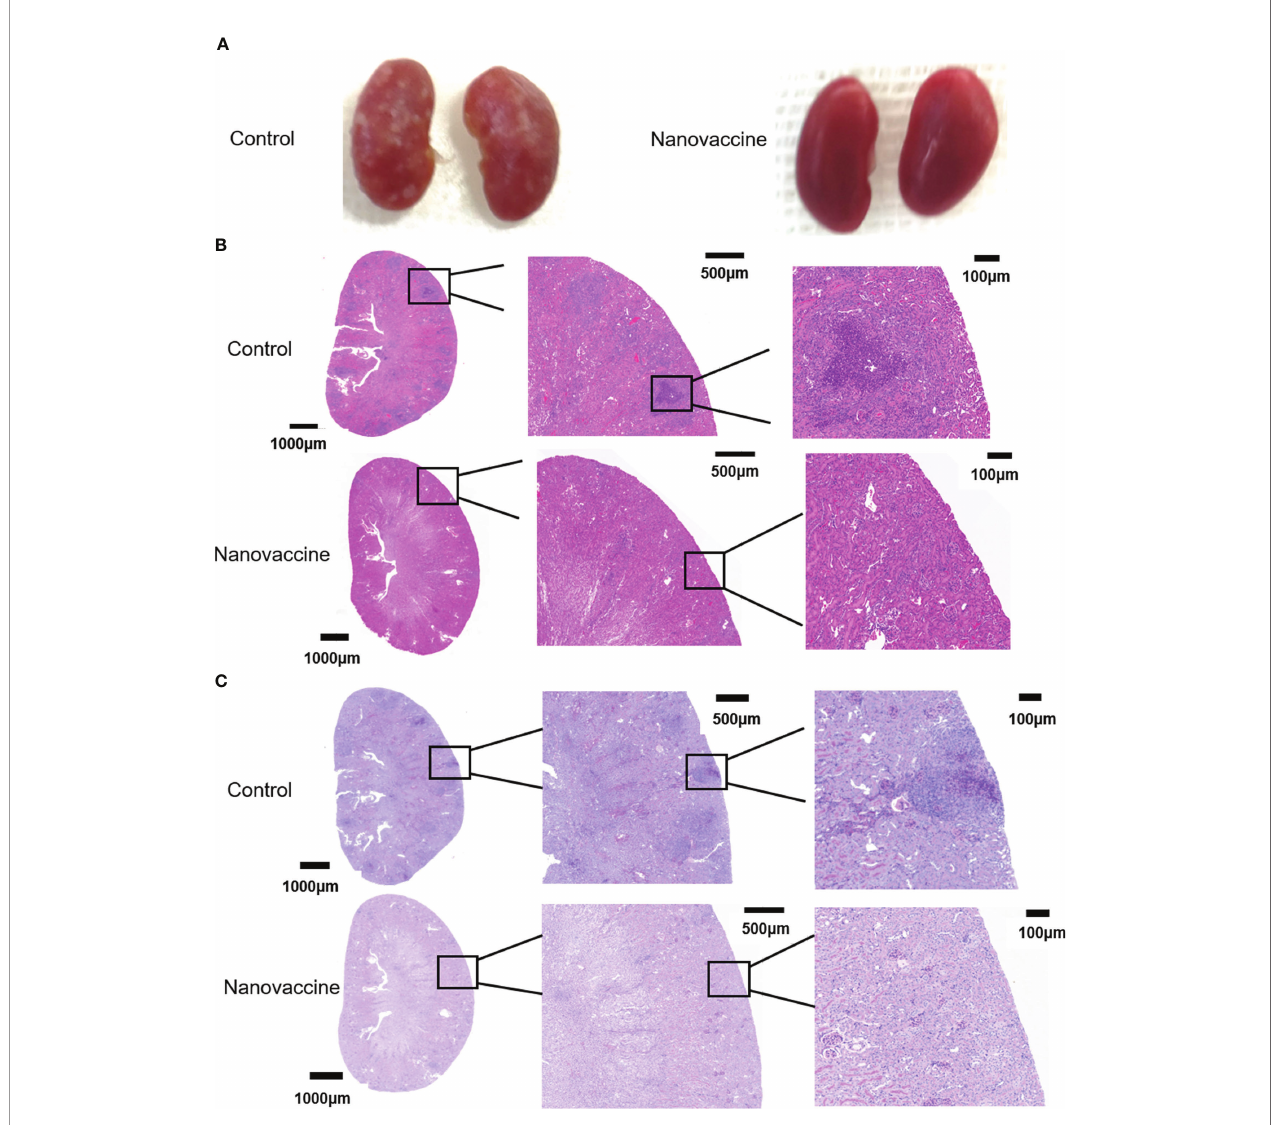
FIGURE 7 | The infected kidneys were protected by the serum of nanovaccine-immunized mice. (A) Kidneys of mice were protected with serum of the control group and the nanovaccine group, respectively. The kidneys of unprotected mice were infested with C. albicans SC5314 and the surface was already covered with it. In contrast, the kidneys of antibody-protected mice had a very smooth surface. (B) Representative H&E staining of kidneys from infected mice with indicated treatment at 48 h post-infection. (C) Representative PAS staining of kidneys from infected mice with indicated treatment at 48 h post-infection. The darker areas framed by red lines were the locations of fungal infestation inside the